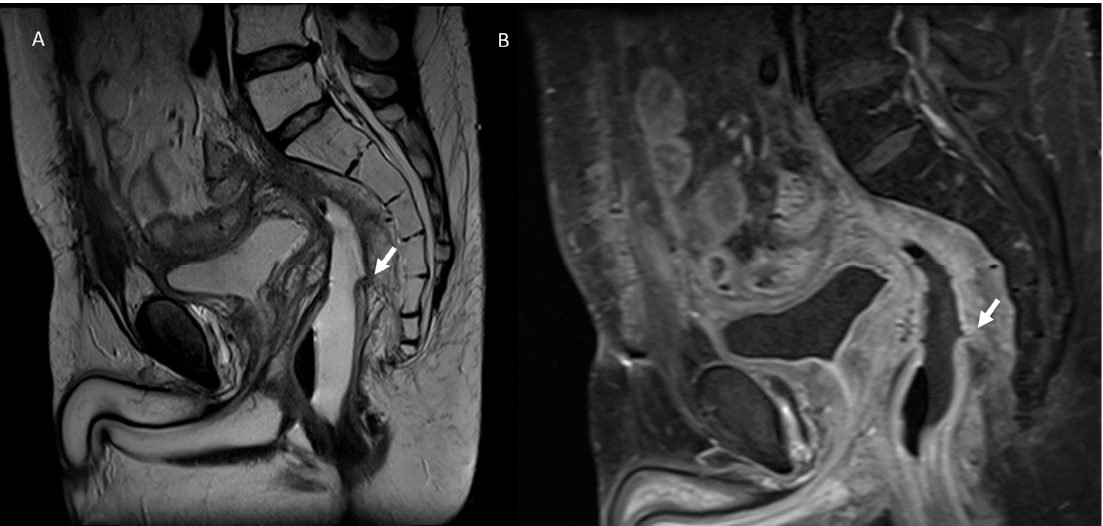
Figure 5. T2-W in sagittal plane ( A ) and T2-W in axial plane ( B ) MRI assessment of post-surgical fistula with sacral plane (arrows).